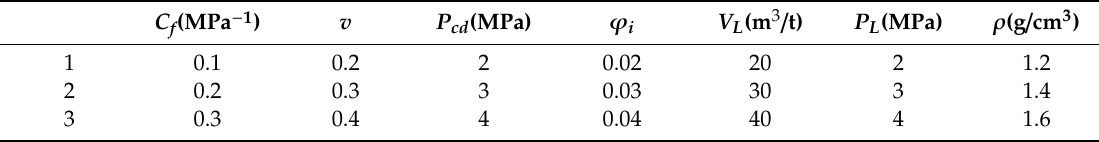
Table 2. Parameters of the orthogonal